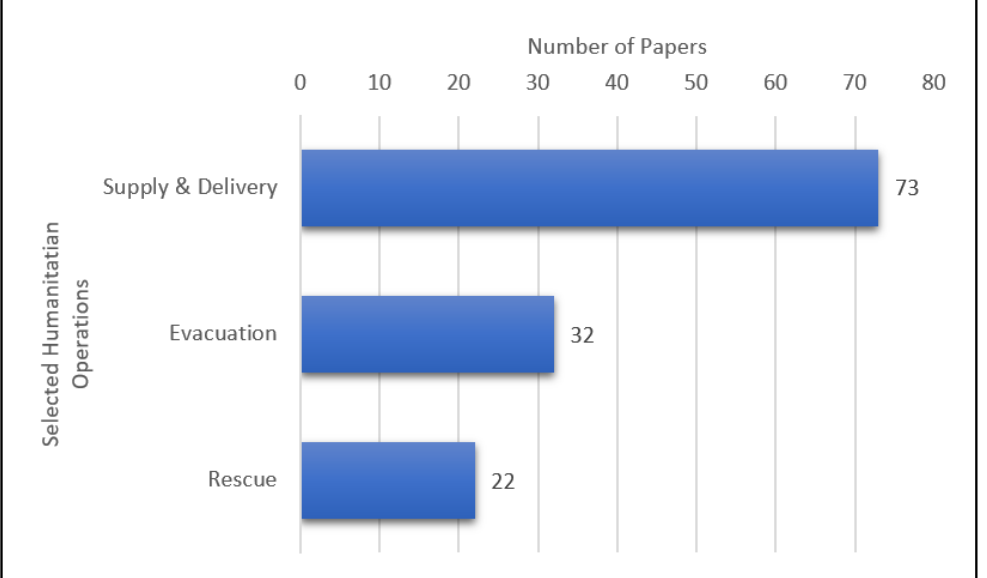
Figure 4. Number of Papers According to Selected Humanitarian